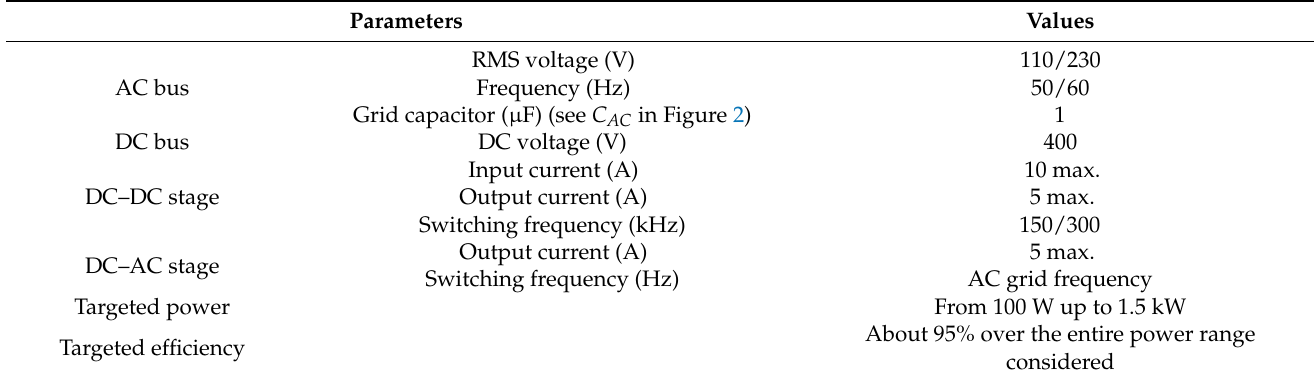
Table 1. The specifications of the proposed bidirectional DC–AC